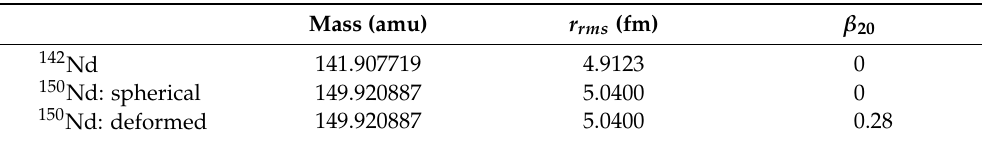
Table 12. Nuclear parameters for Nd